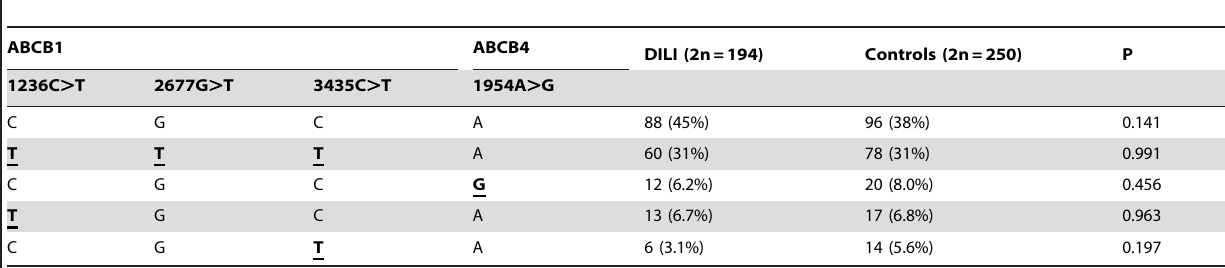
Table 6. Predicted allele combination frequencies of transporter gene